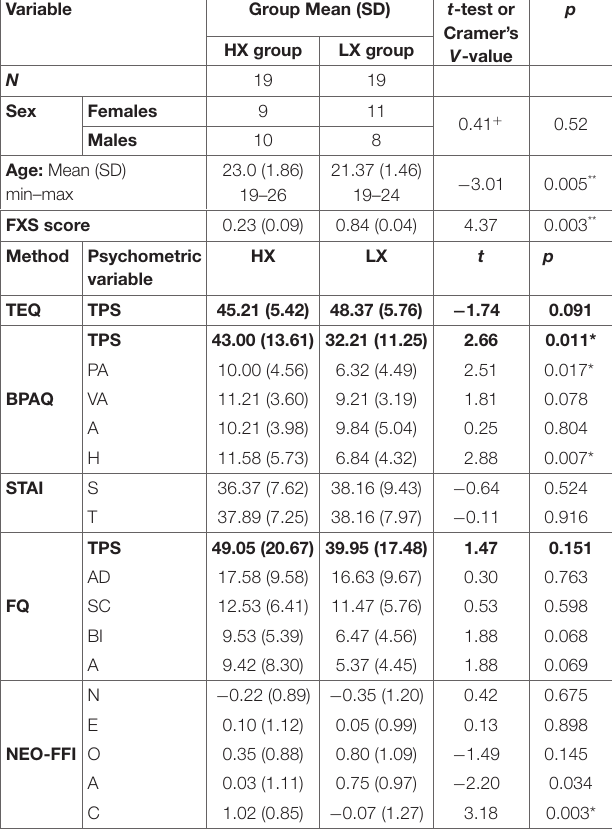
TABLE 1 | A comparison of demographic and psychometric data for the LX and HX groups.